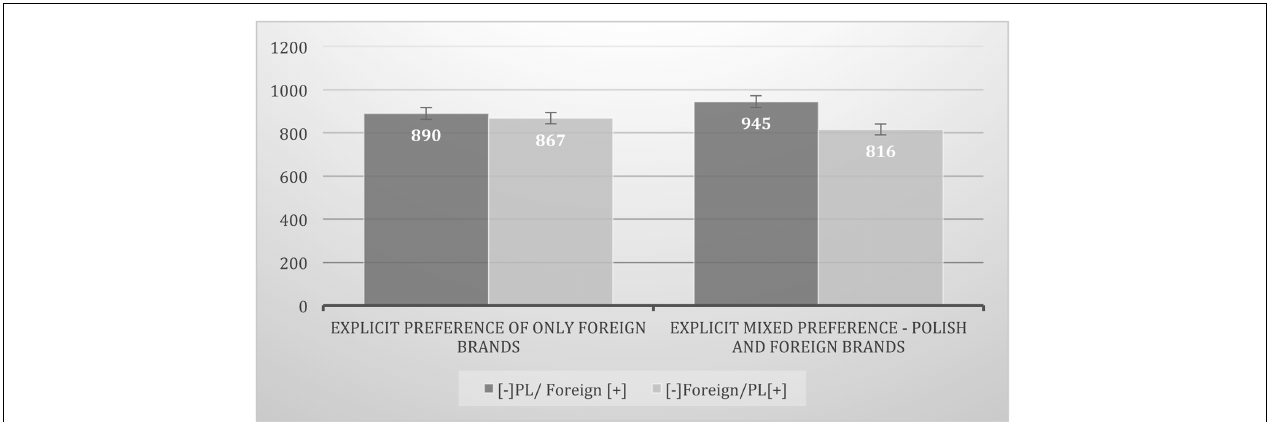
FIGURE 2 | Comparison of Implicit Consumer Ethnocentrism (ICE) toward Polish vs. foreign brands (IAT effect) among people who prefer on explicit level: (a) only foreign brands and (b) those with mixed preference for foreign and Polish brands. Categorization time in milliseconds